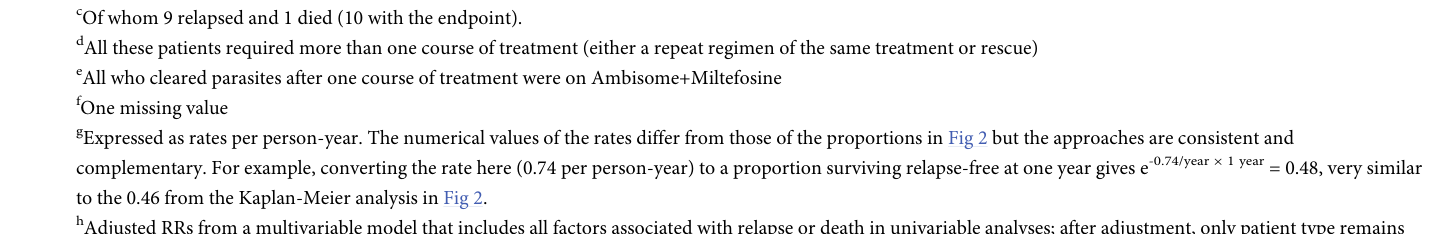
The probability of relapse-free survival at one year was 50% (95% CI: 35–63%) in all patients. One limitation of this study was that it was not adequately powered to test differences between the two sub-groups; CD4 � 200 cells/ μ L without pentamidine versus CD4 < 200 cells/